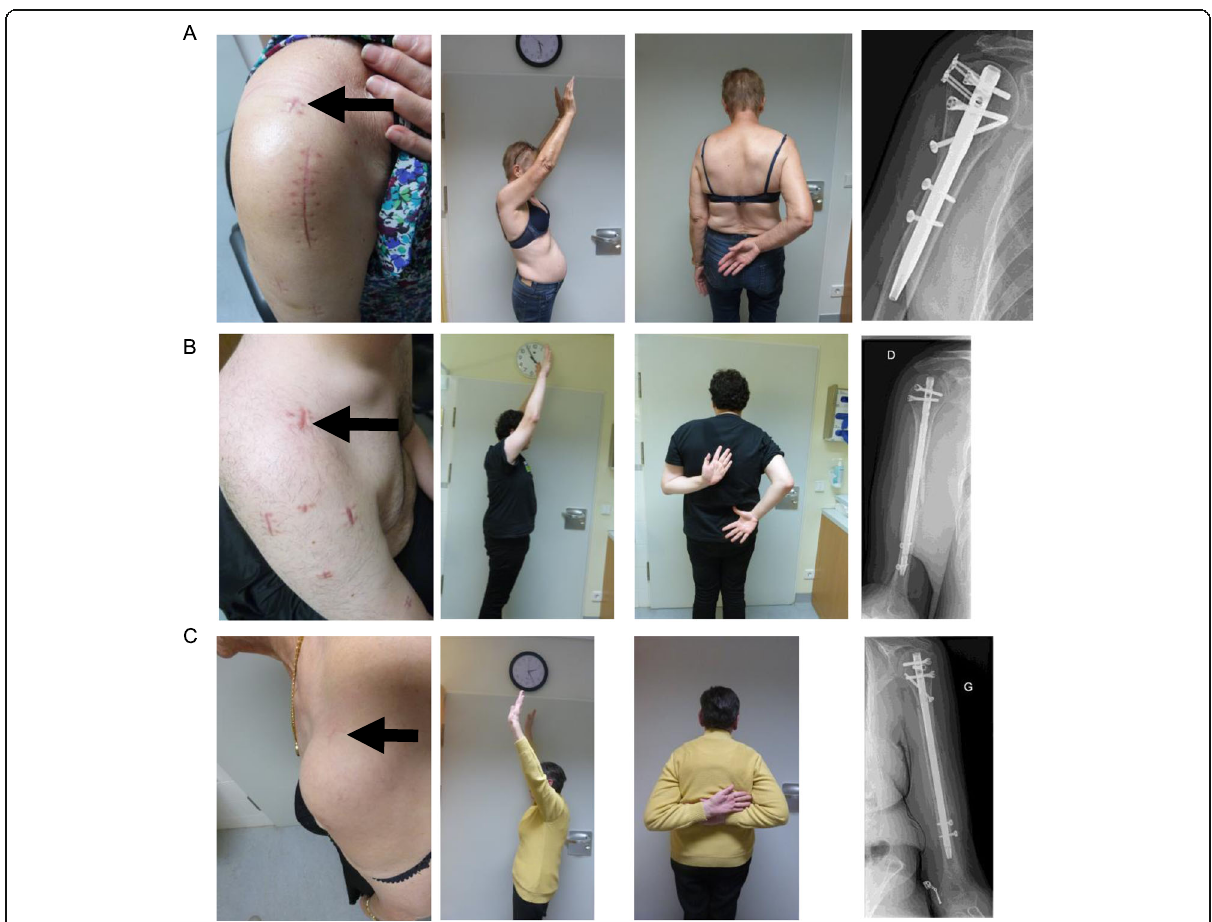
Fig. 2 For nail insertion over Neviaser ’ s portal only a 1 cm incision is needed. Underlying soft-tissue structures are bluntly dissected. Skin incision is marked with a black arrow. D.C.P. female patient, 69 years. Three-part-fracture, an additional delta-split approach was necessary to reduce and stabilize an avulsed greater tubercle. Clinical and radiological follow-up at 8 months postoperative a . T.K. male patient, 24 years. Diaphyseal fracture, Clinical and radiological follow-up at 4 months postoperative b . U. female patient 66 years. Metaphyseal fracture. Clinical and radiological follow-up at 11 months postoperative